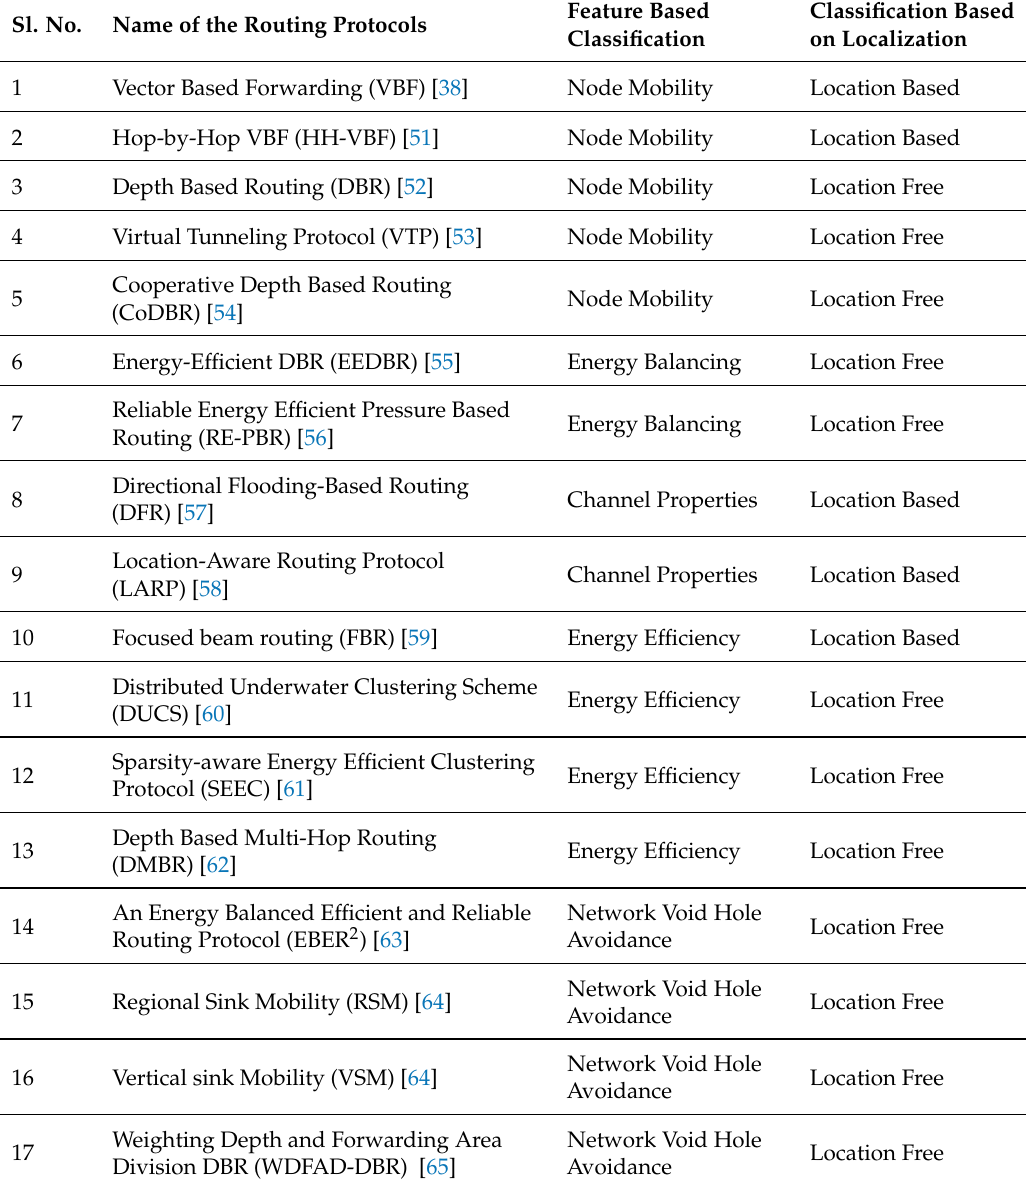
Table 2. Classification of Routing